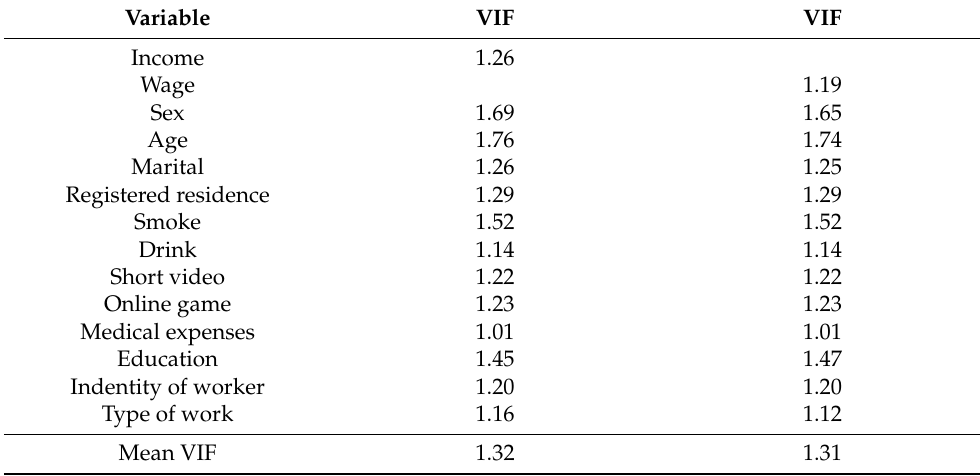
Table 2. The variance inflation factor of each variable.